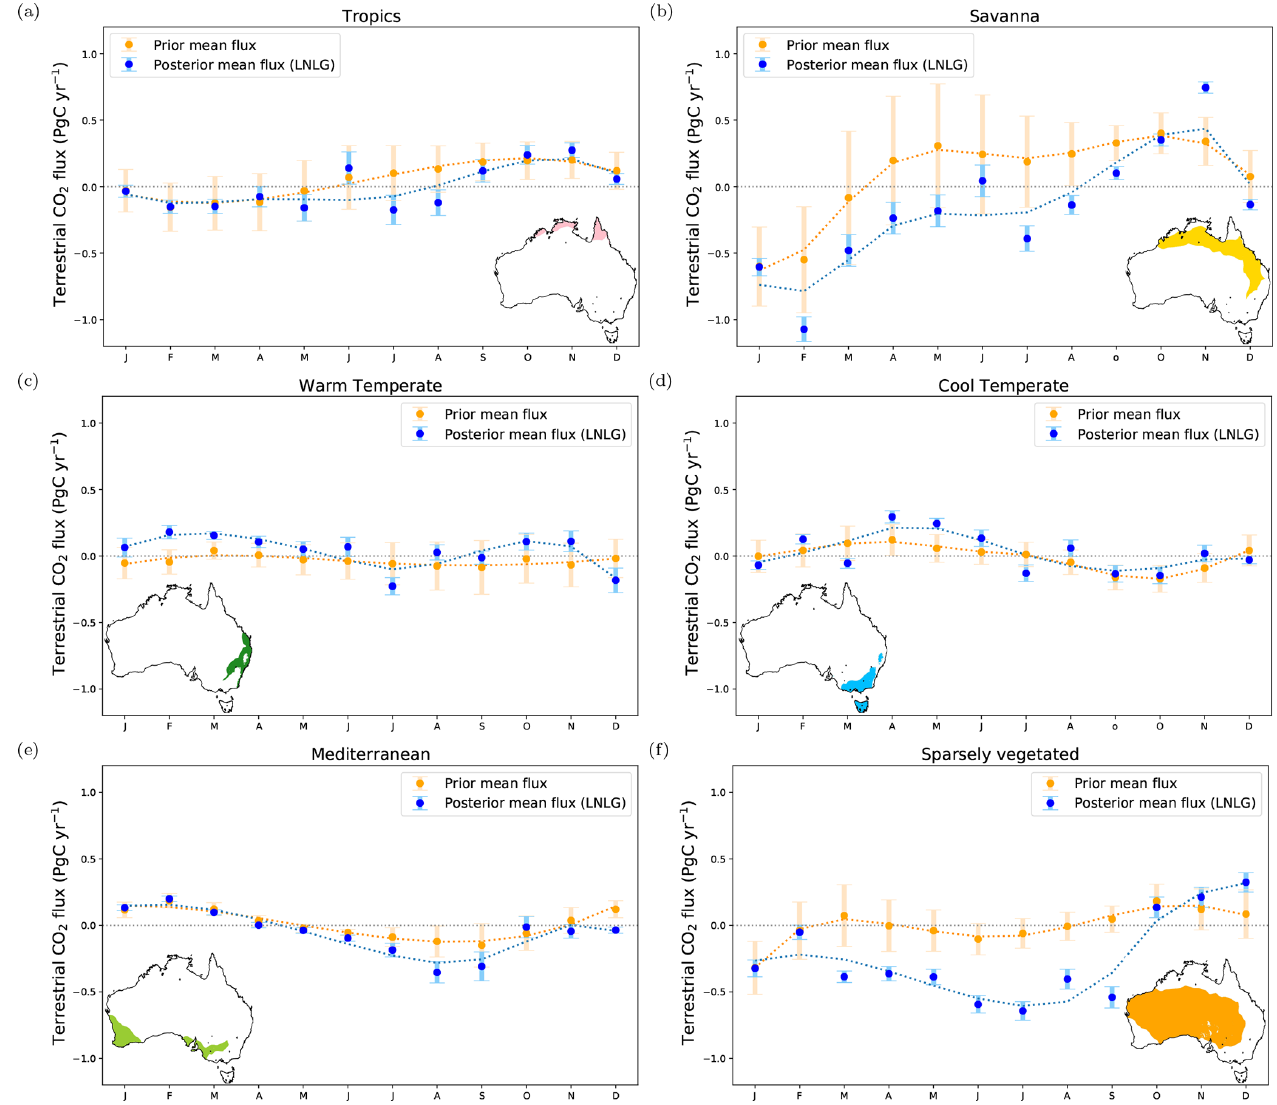
Figure 9. Monthly time series of the Australian land biosphere prior and posterior CO 2 flux and their uncertainties in PgCyr − 1 aggregated over six bioclimatic regions. The prior and posterior estimates do not include fossil fuel